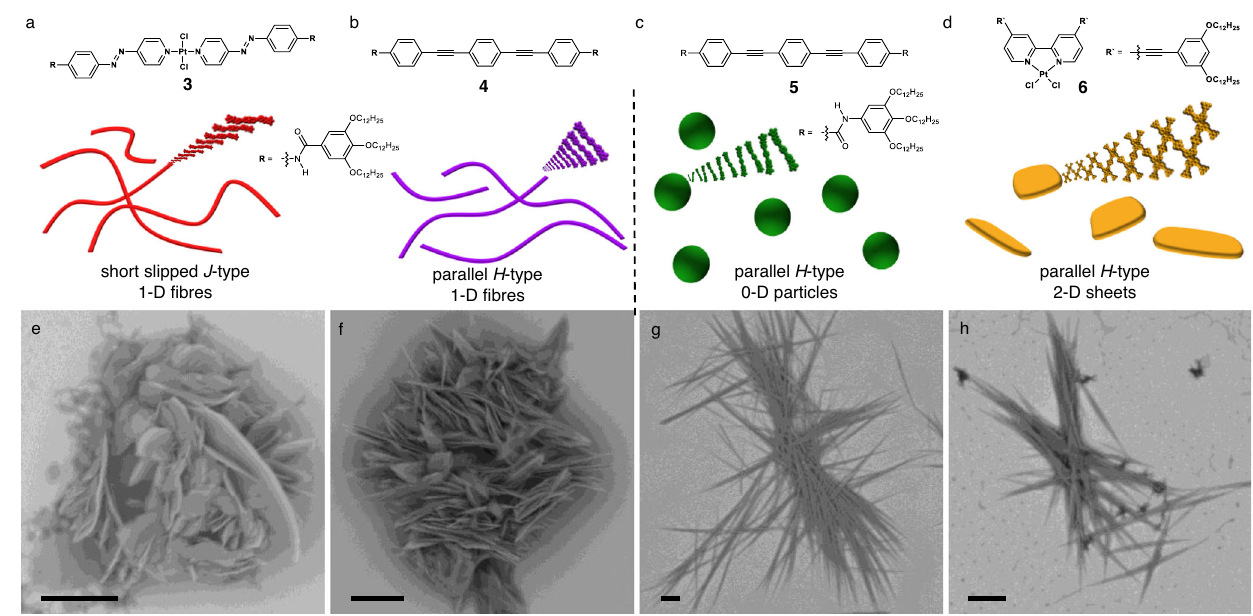
Fig. 5 | Generalizability assessment of self-assembly induced by supramole- cular crowding. a – d chemical structures and schematic supramolecular self- assembly behaviour of crowding agents 3 , 4 , 5 and 6 . e – h SEM micrographs of